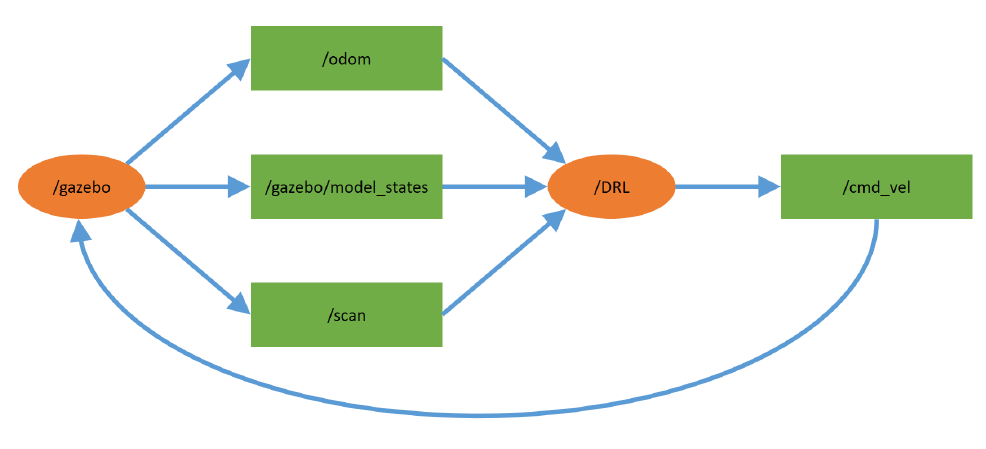
Figure 1. The practical topology used in the